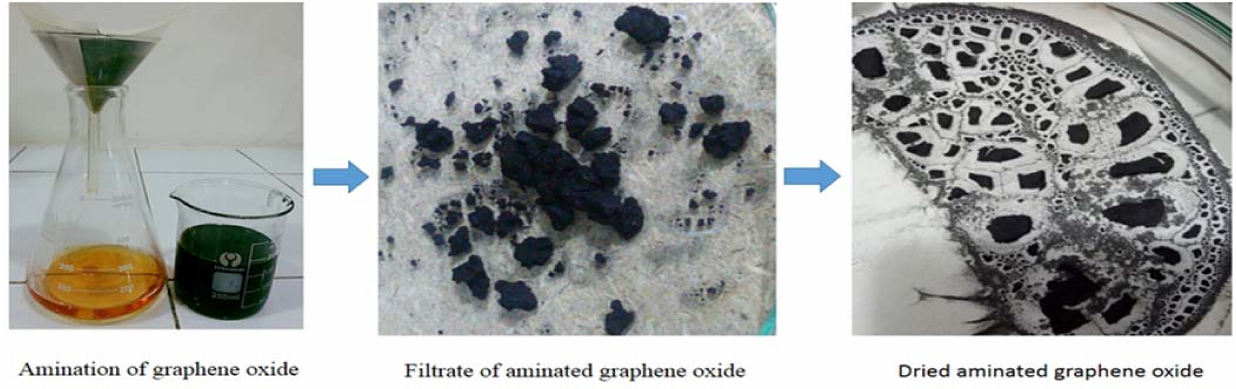
Figure 2. Schematic representation of the synthesis of aminated graphene oxide. Table 1. Compositions of different fabricated nanocomposite membranes.